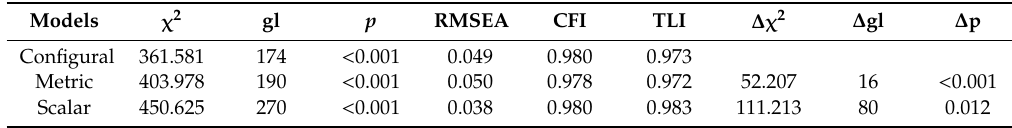
Goodness of fit indices of nested model of factor invariance analysis according to sexual